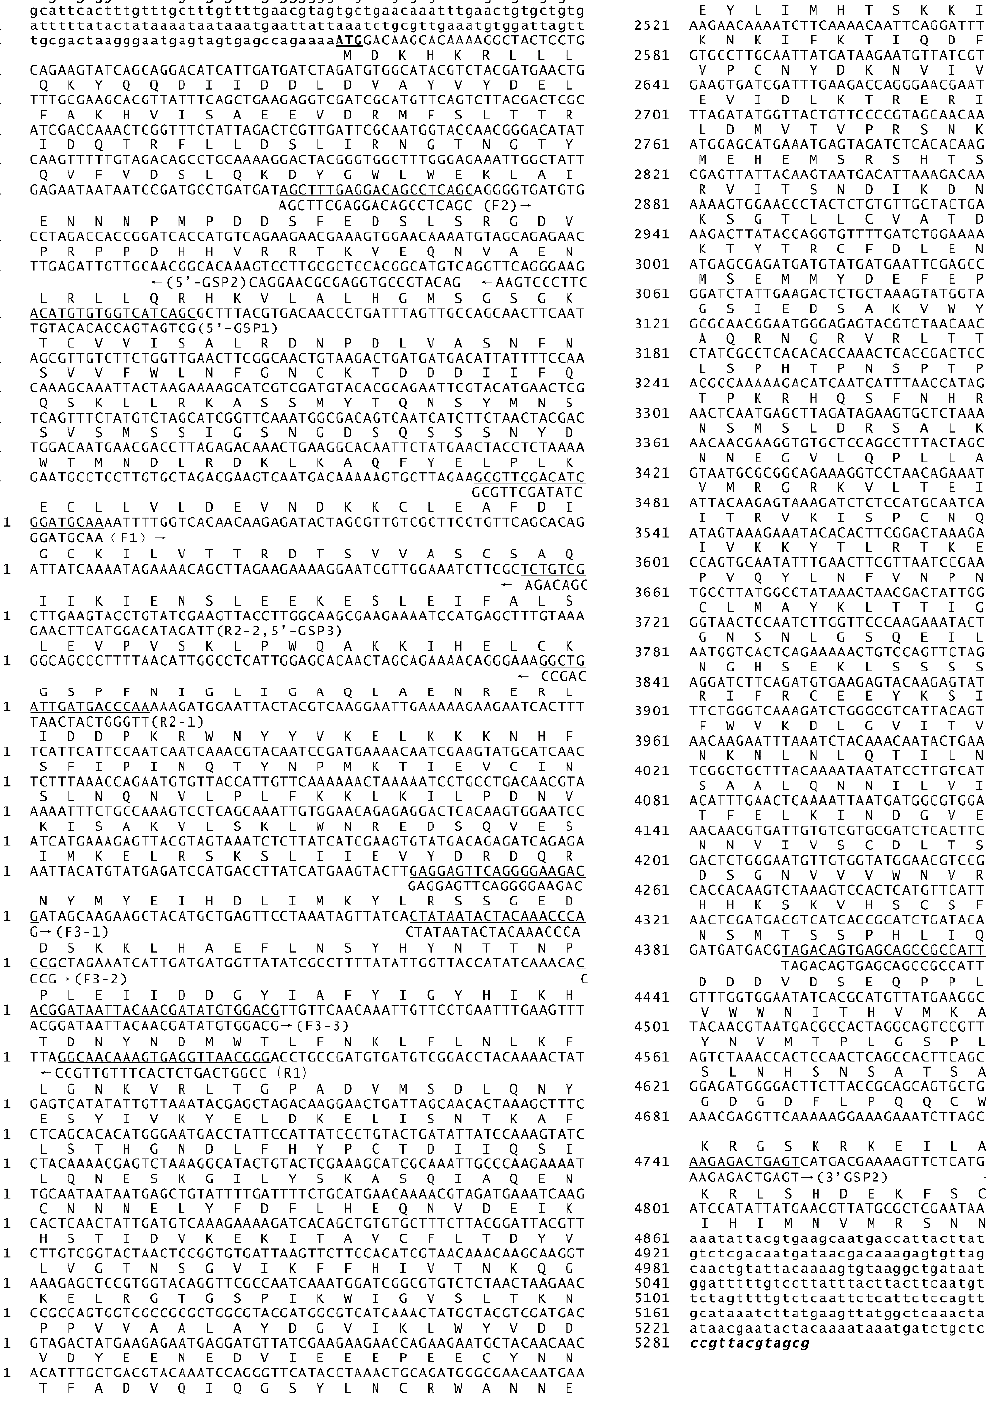
Figure 1. Sequence of S l-apaf-1 cDNA and predicted amino acids. The complete cDNA consists of 5221 bp and contains an open reading frame of 4626 bp that encodes 1542 amino acids. The start codon and stop codons are underlined.